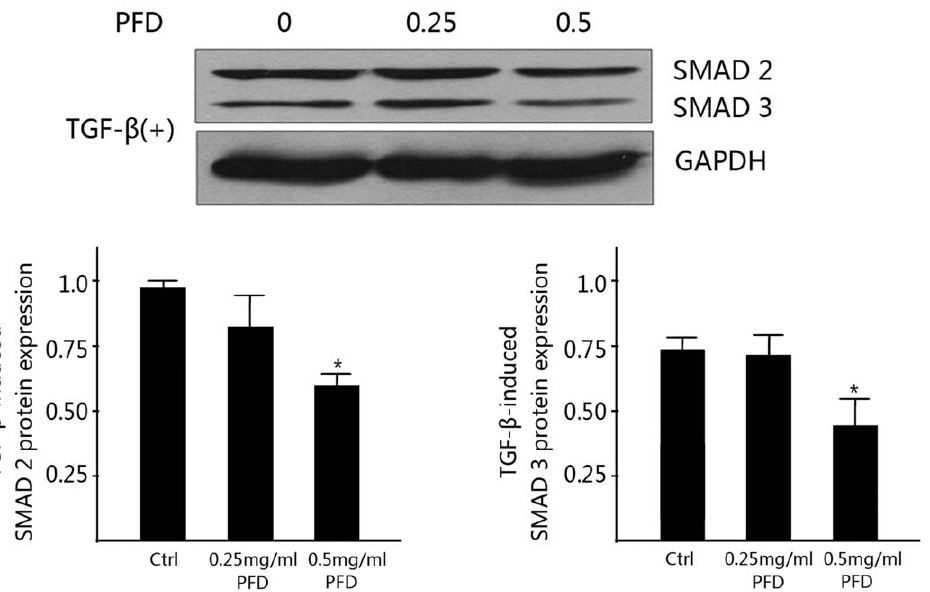
Figure 10. Inhibitory Effect of PFD on TGF- b 2-induced Expression of SMADs protein. Western blot showed that pirfenidone (0.5 mg/ml) reduced the TGF- b 2-induced Expression of SMAD2 and SMAD3 when compared with control cells. The inhibitory effects could be detected but were not statistically significant in the 0.25 mg/ml PFD groups. *P , 0.05 versus the corresponding value for control cells. Data are mean 6 SD of results from three independent cultures.